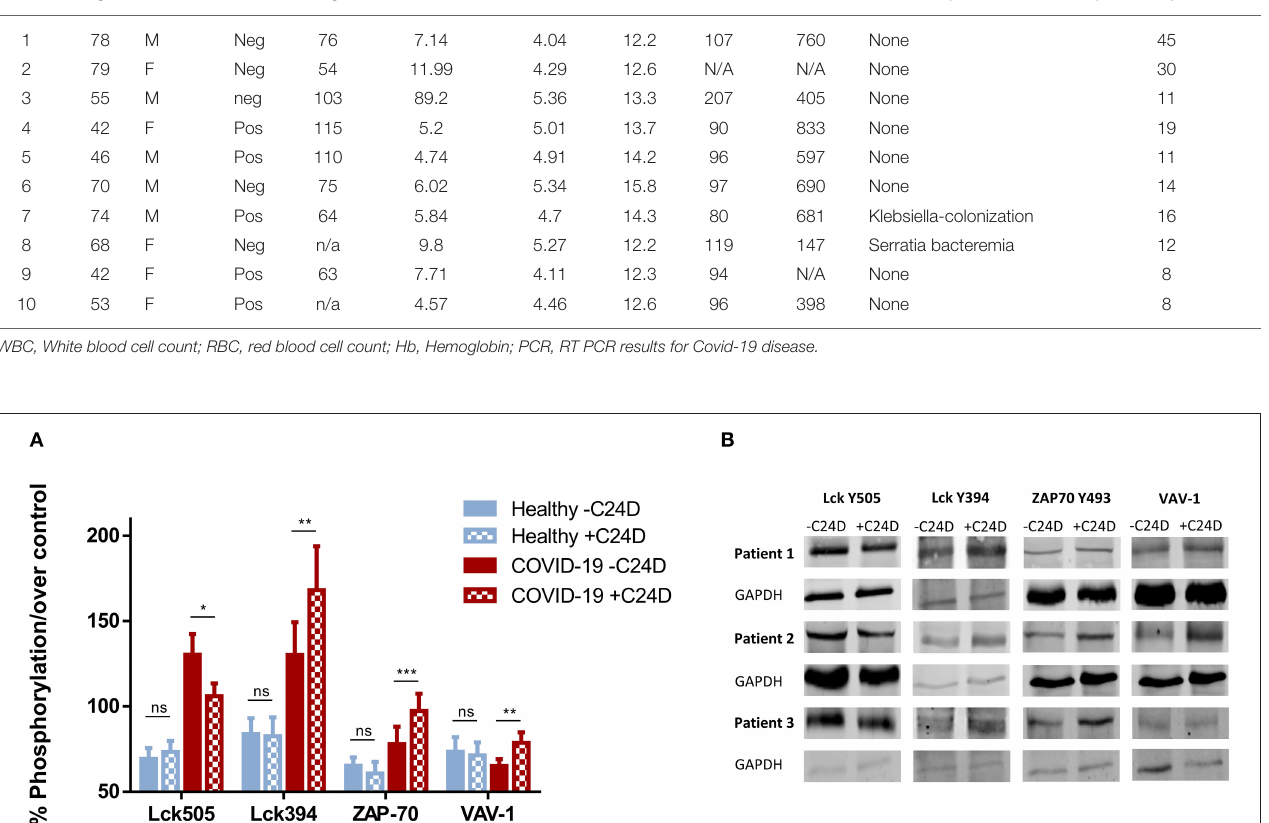
Frontiers in Medicine |